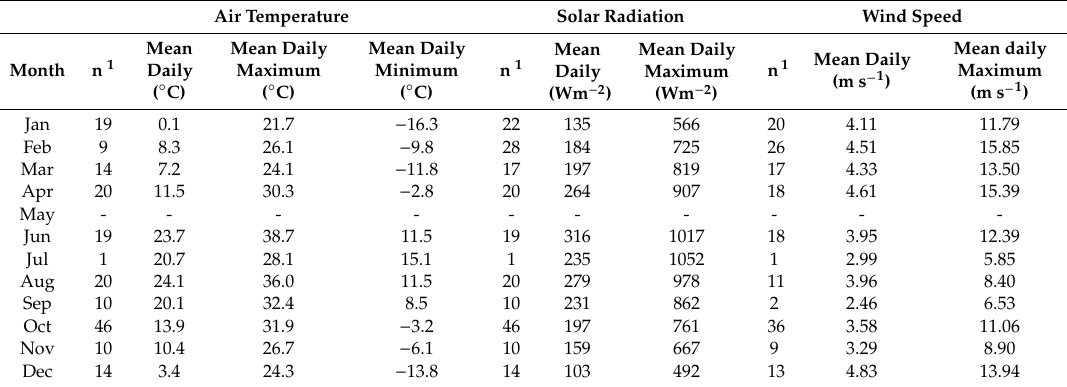
Table 3. Aggregate monthly weather conditions during the two-year